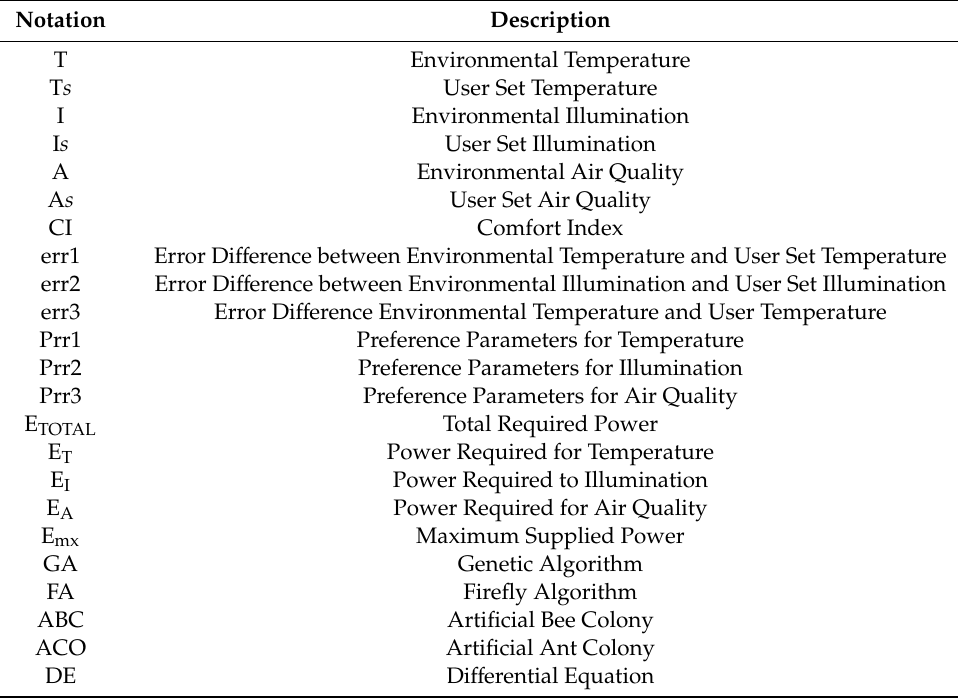
Table 1. Notations with